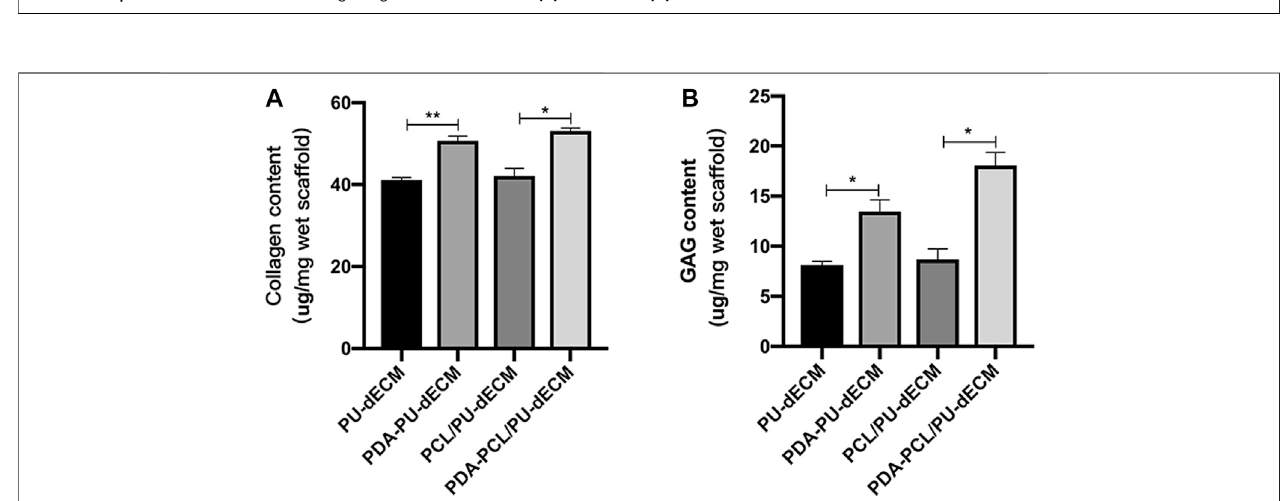
FIGURE 7 | Biochemical analysis for collagen and GAG quanti fi cation. (A) Collagen content of the scaffolds; (B) GAG content of the scaffolds. (*Comparison between original groups and modi fi ed groups, n (cid:2) 3, * p < 0.05, ** p < 0.01).